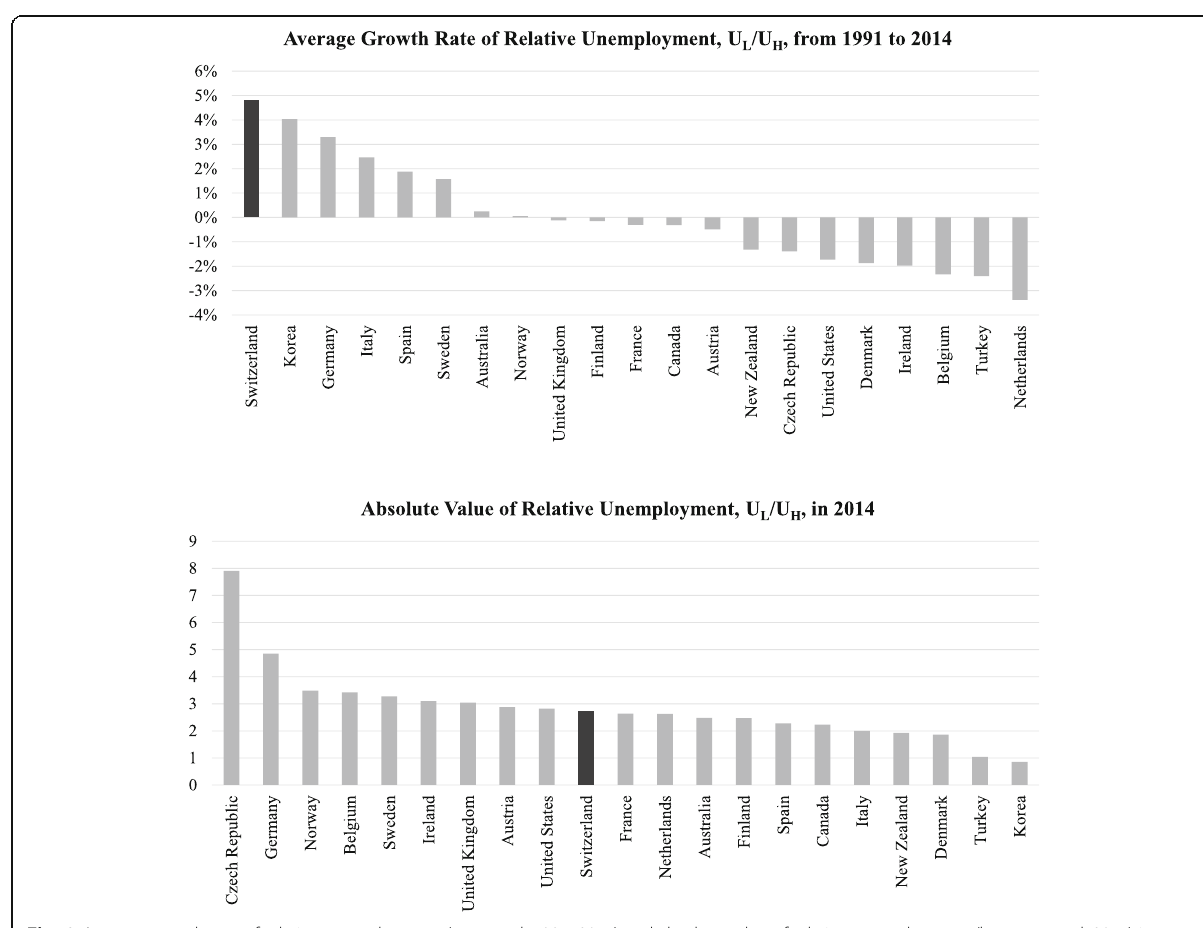
Fig. 2 Average growth rate of relative unemployment (top panel, 1991 – 2014) and absolute value of relative unemployment (bottom panel, 2014) in OECD countries. Note: These are OECD countries for which data were available for the years considered. For the comparison in the top-panel, compounded average growth rates were taken. Source: Own calculations based on OECD (2007) and OECD (2015), Tables A8.4a and A5.4a,